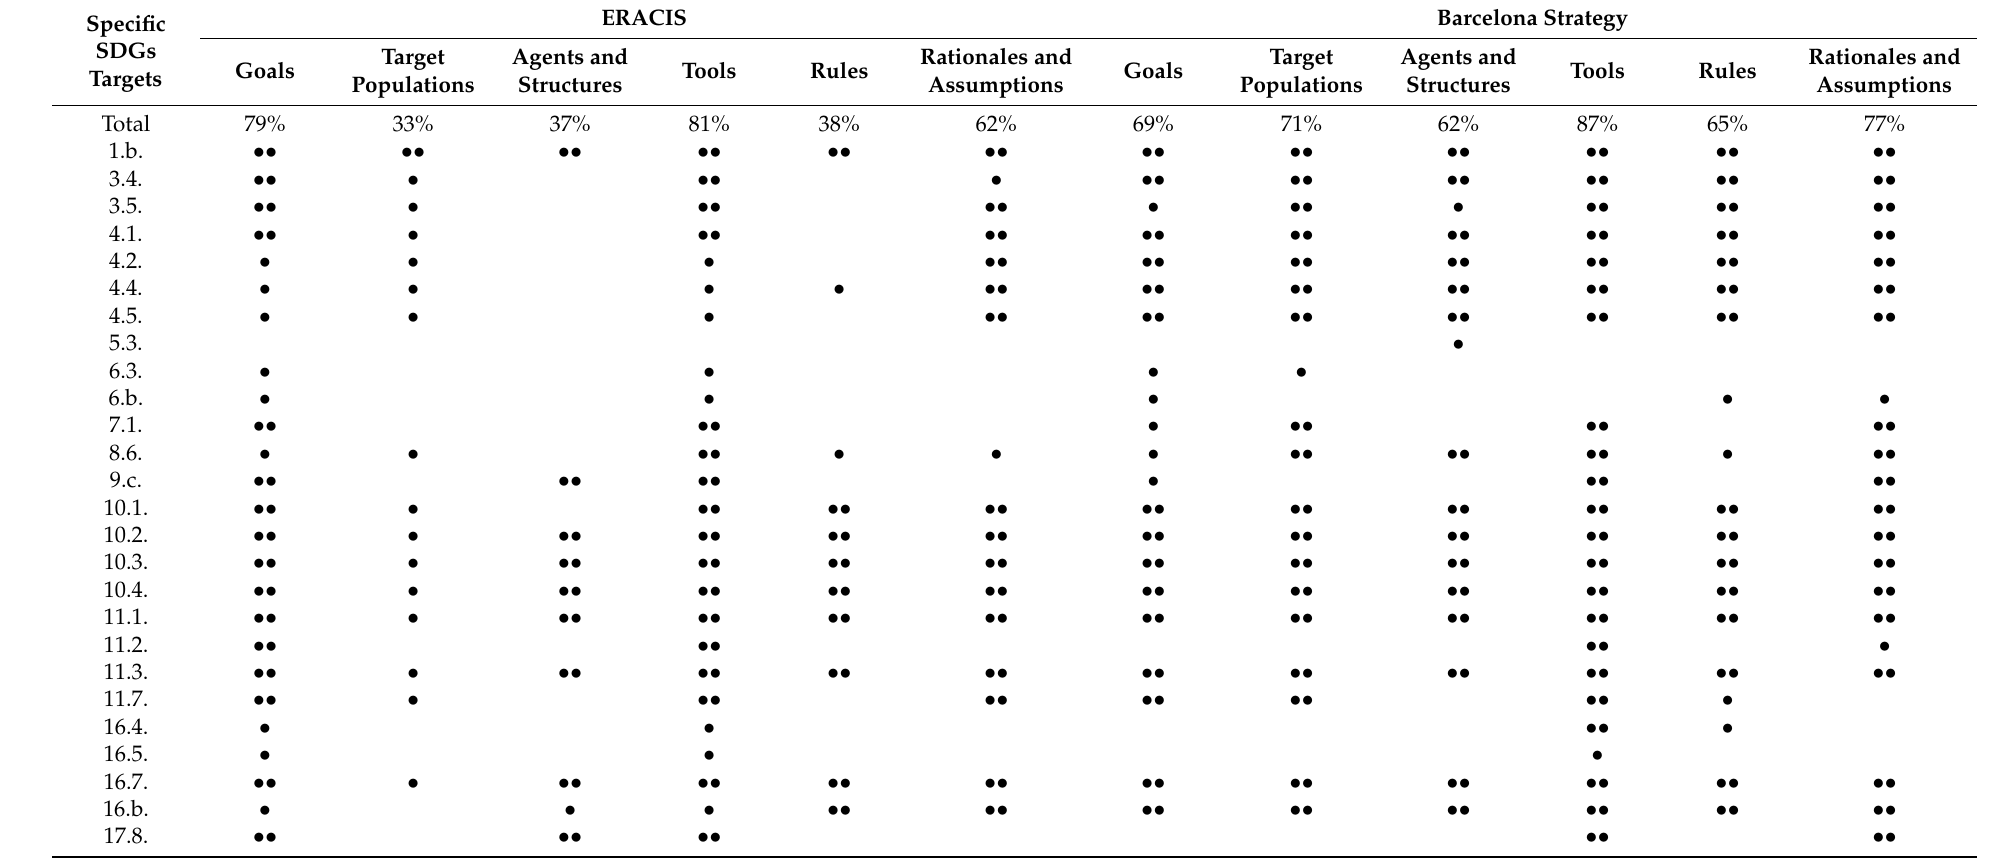
Table 3. Specific SDGs in ERACIS and Barcelona